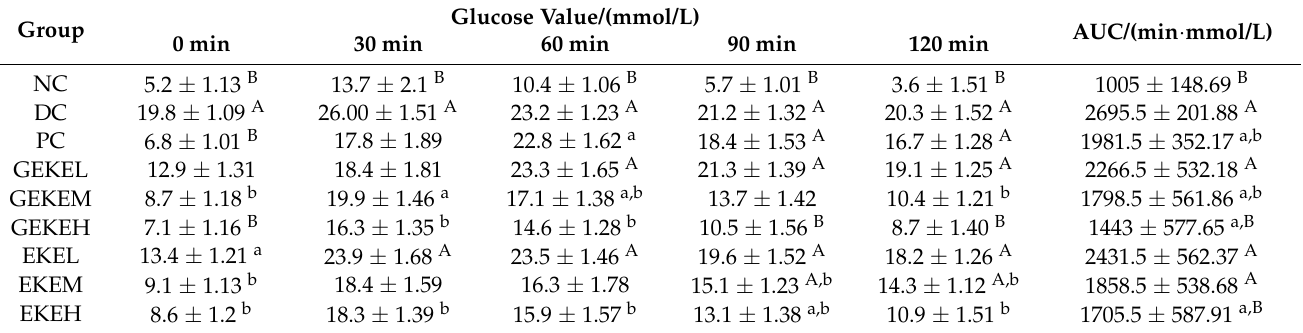
Table 5. Oral glucose tolerance test in each group of mice (x ± s, n = 10).